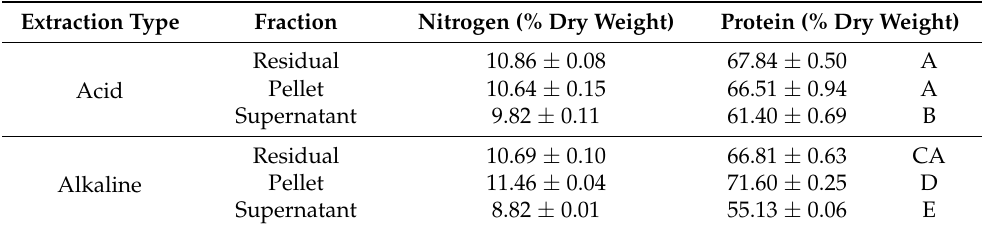
Table 1. Percentage of cricket protein content in the different fractions obtained by acid and alkaline type extractions.